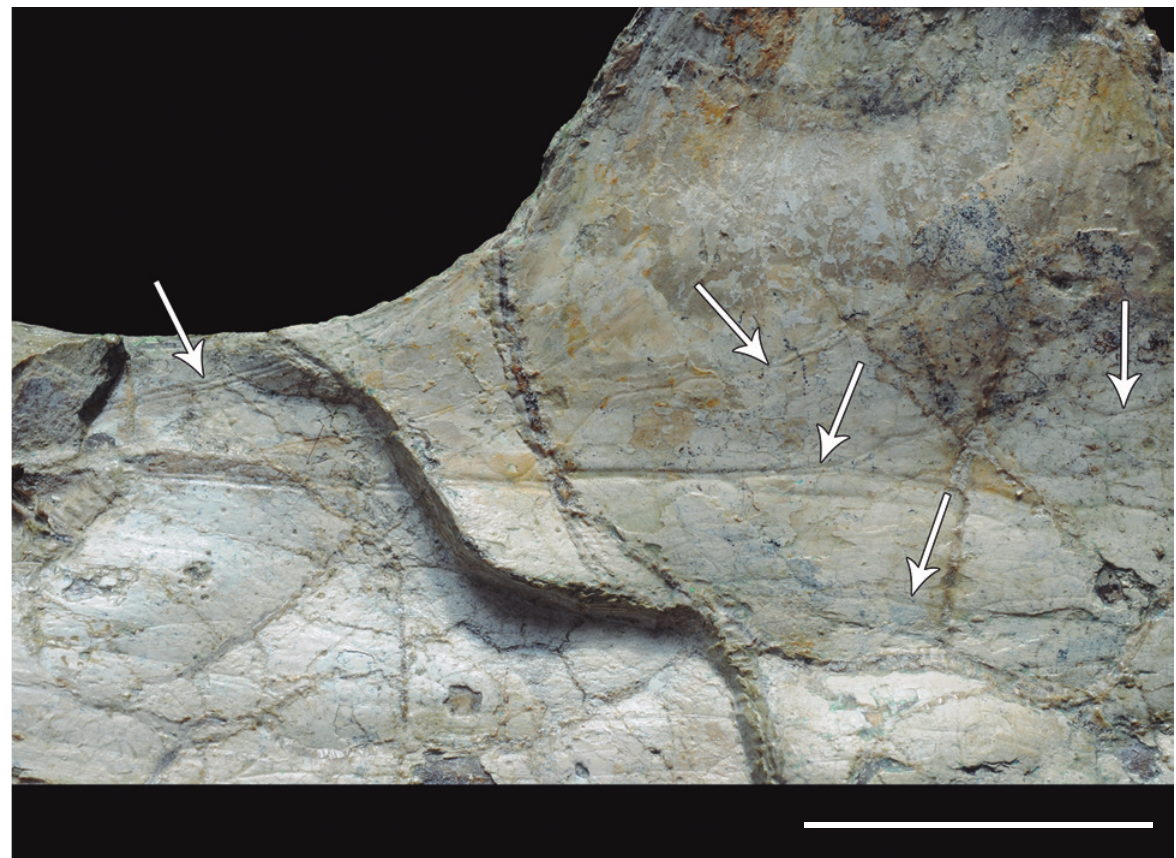
Fig. 4 - Incomplete rostrum of Tropeognathus cf. T. mesembrinus (MN 6594-V) in right lateral view. Arrows indicate channels, regarded as impressions of blood vessels. Scale bar 50